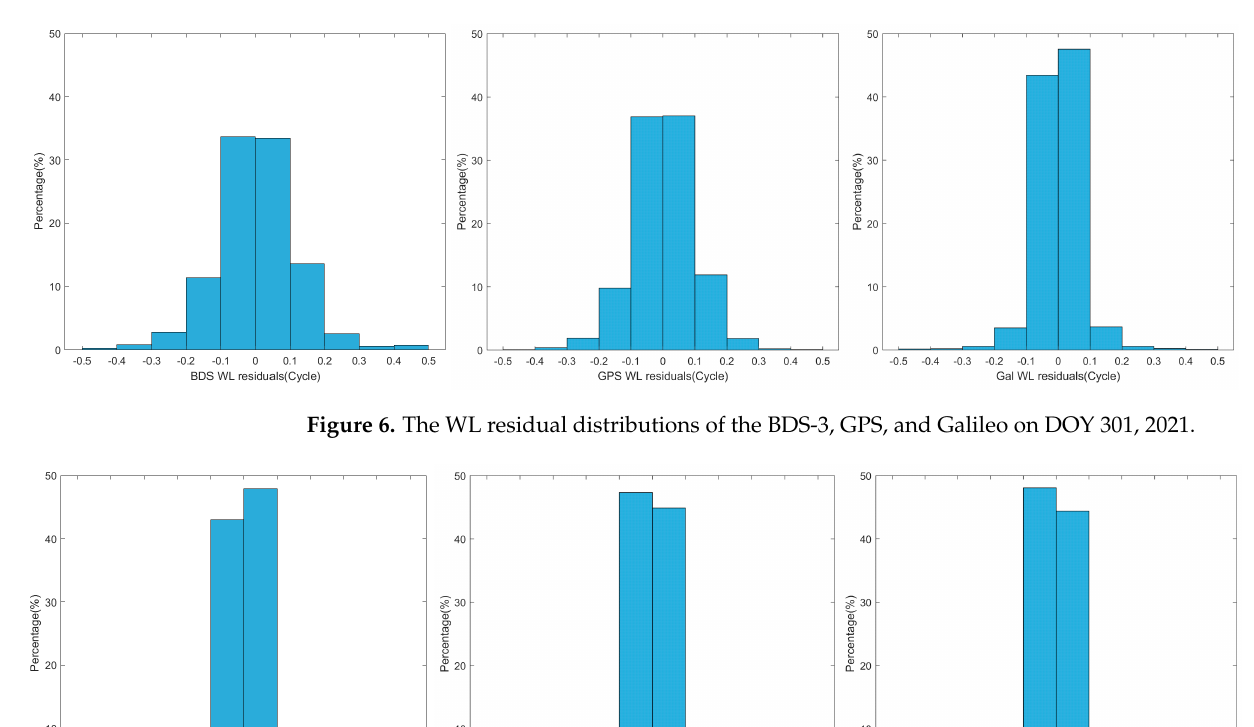
Remote Sens. 2022 , 14 , 4207